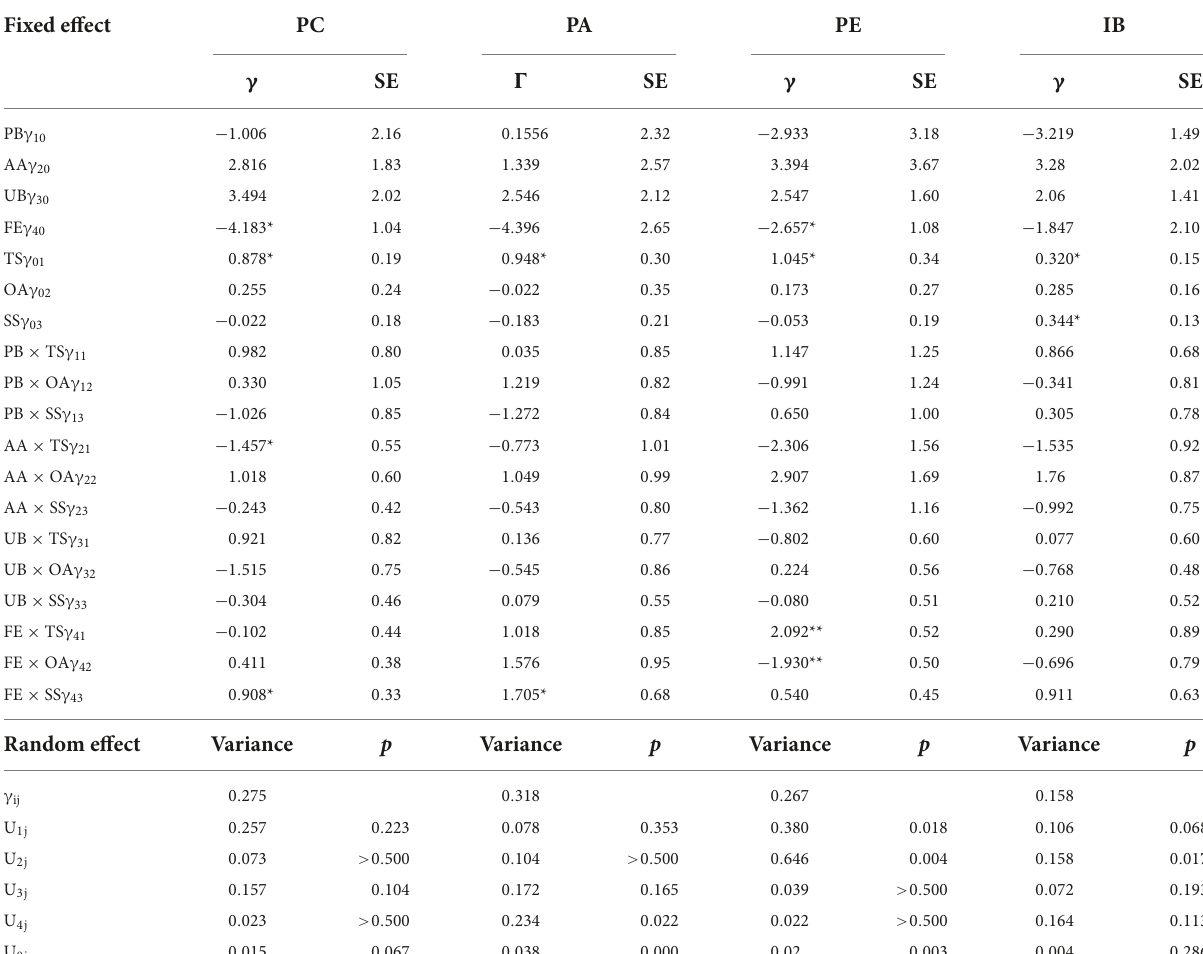
TABLE 5 Summary of slope prediction